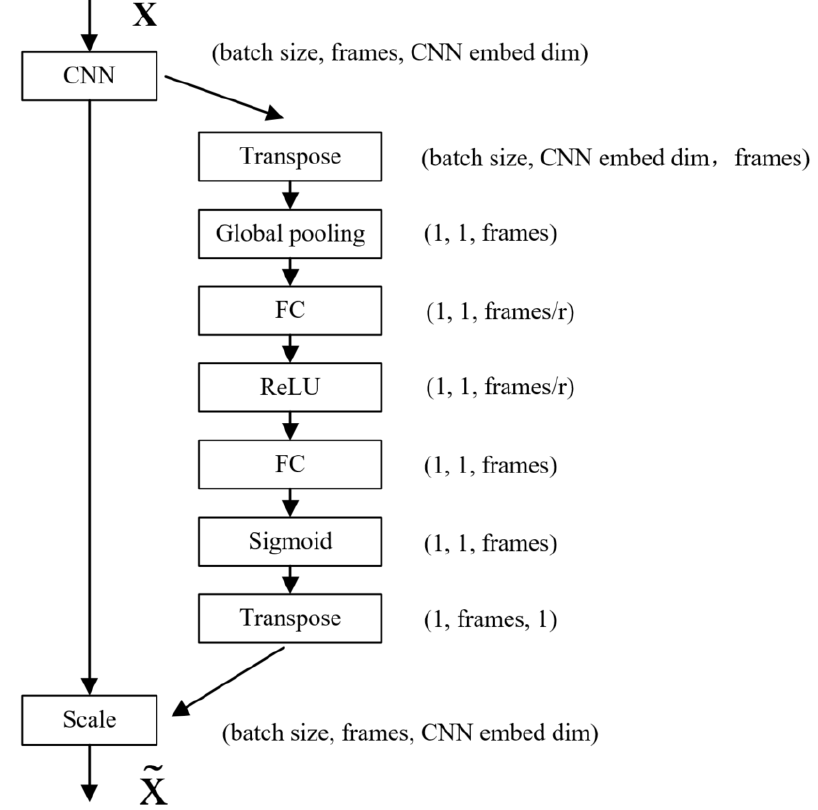
Figure 9. Frame attention mechanism structure.